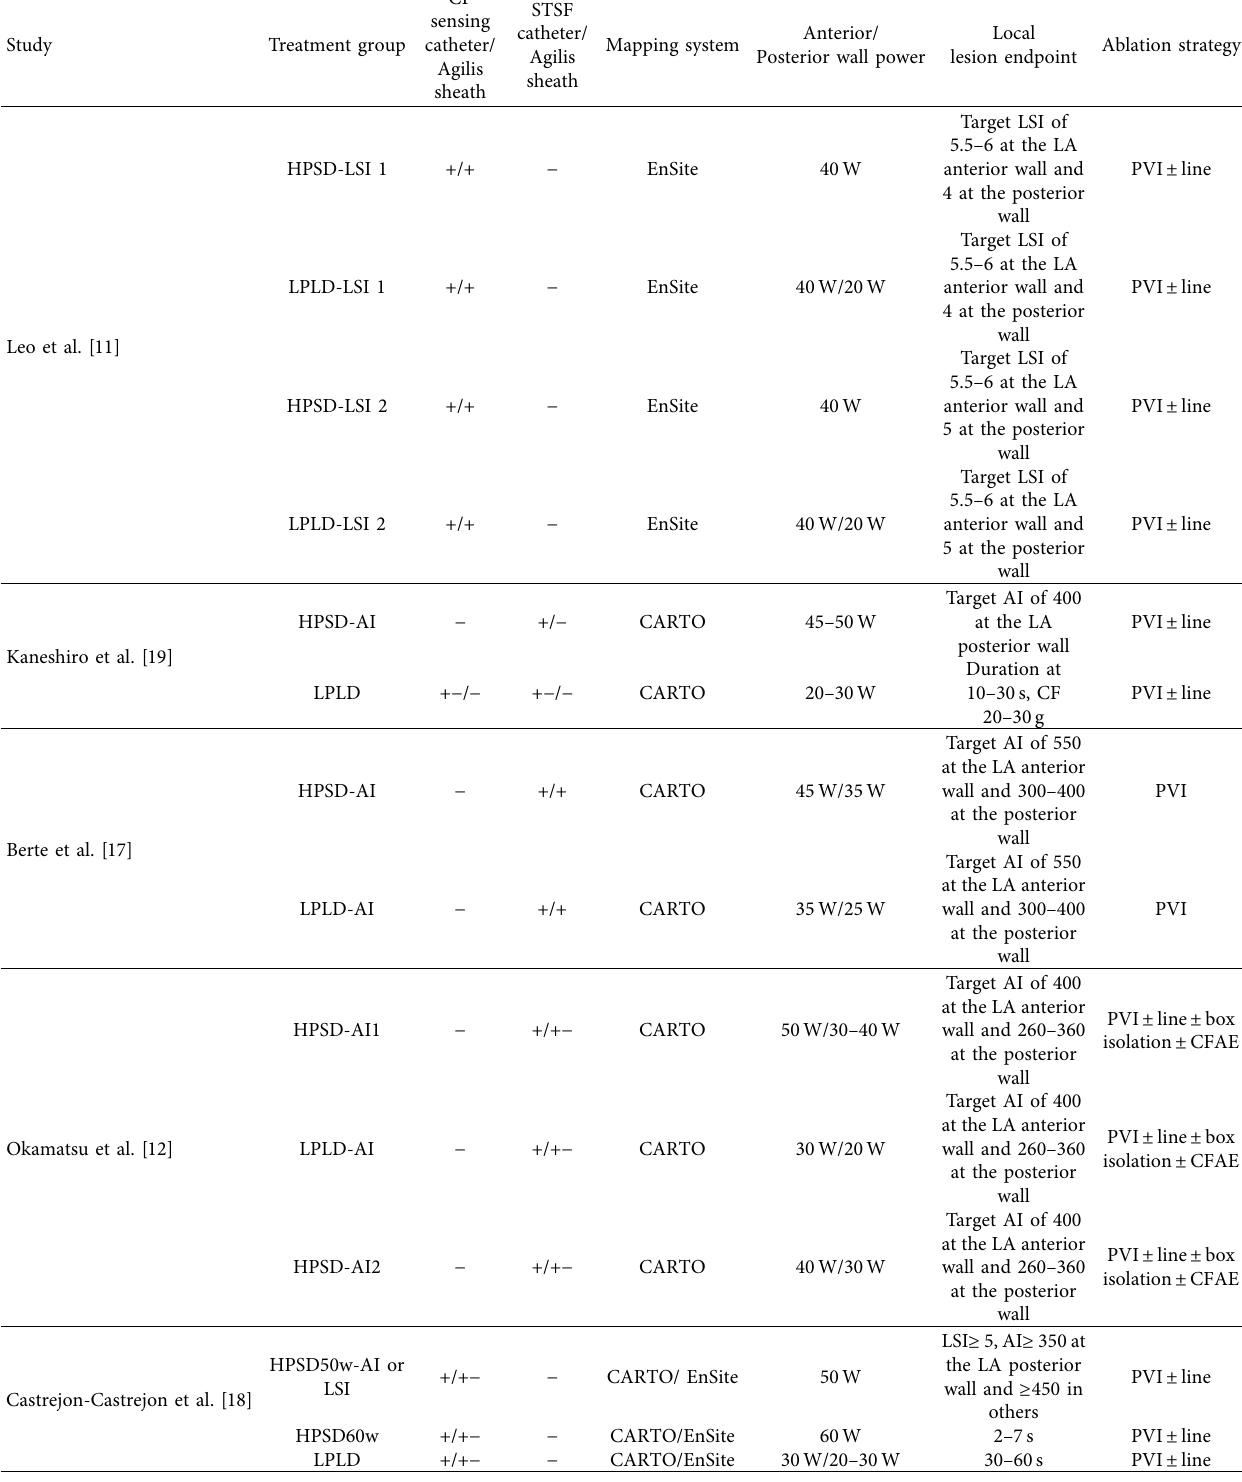
Table 2: Procedural